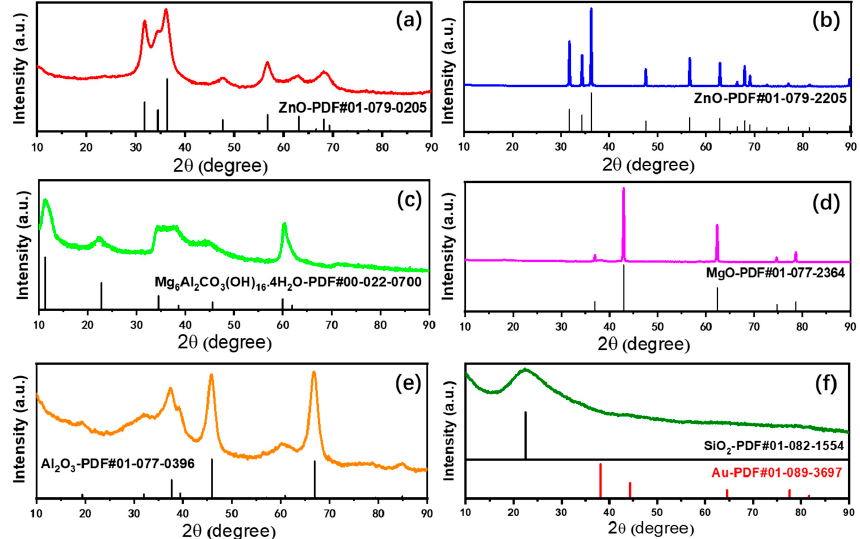
Figure 2. X-ray diffraction patterns of different supported gold catalysts; ( a ) Au 25 /ZnAl-300; ( b ) Figure 2. X-ray di ff raction patterns of di ff erent supported gold catalysts; ( a ) Au 25 / ZnAl-300; Au 25 /ZnO-300; ( c ) Au 25 /MgAl-300; ( d ) Au 25 /MgO-300; ( e ) Au 25 /Al 2 O 3 -300; ( f ) Au 25 /SiO 2 -300. ( b ) Au 25 / ZnO-300; ( c ) Au 25 / MgAl-300; ( d ) Au 25 / MgO-300; ( e ) Au 25 / Al 2 O 3 -300; ( f ) Au 25 / SiO 2 -300.